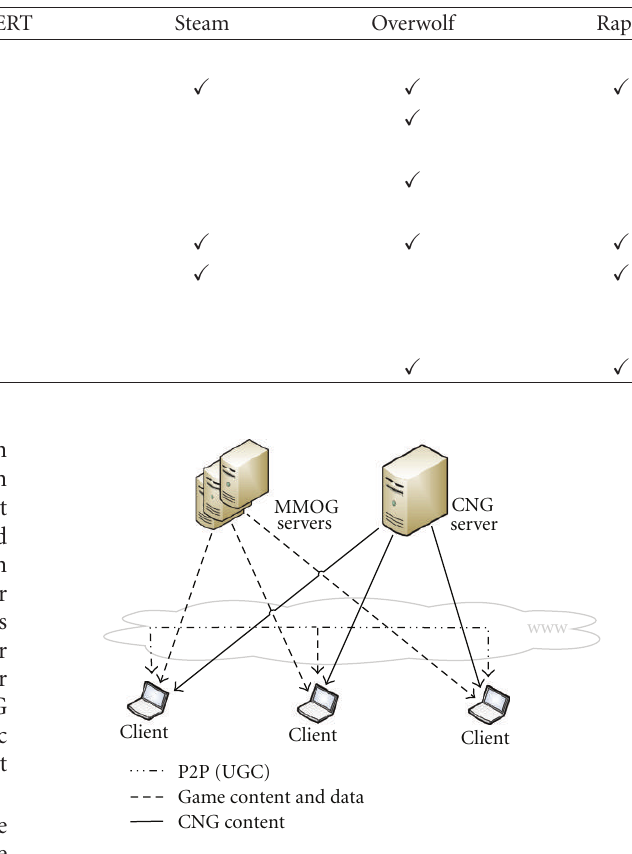
Figure 1: The CNG network architecture (source